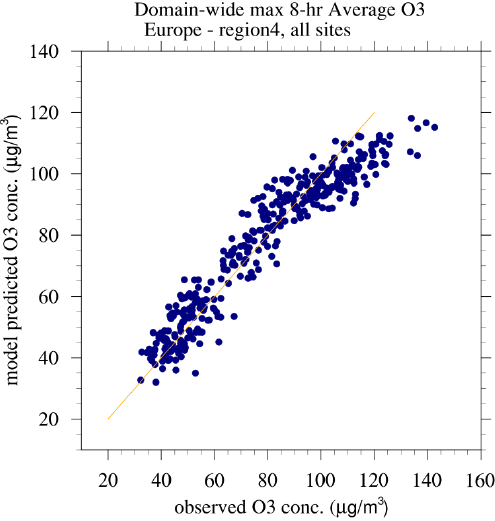
Figure 12. Scatter plot of maximum 8h running average ozone con- centration in central Europe.